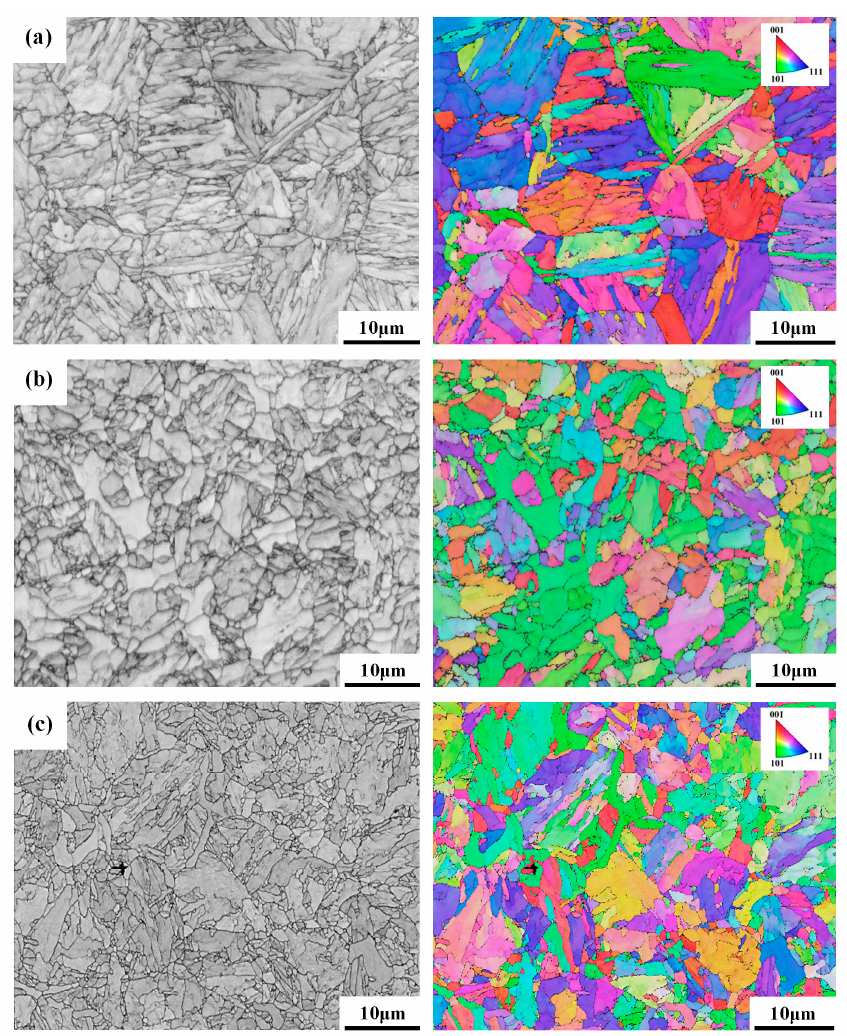
Figure 4. SEM micrographs (left) and electron backscatter diffraction (EBSD) maps (right) of the: ( a ) STOT; ( b ) ICHAZ; and ( c ) FGHAZ specimens after PWHT.